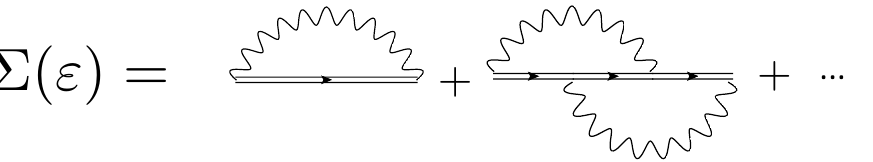
Figure 12: Diagrammatic expansion for the self-energy. Double line corresponds to bold Green’s function. Wavy line stands for the correlator of Gaussian classical random